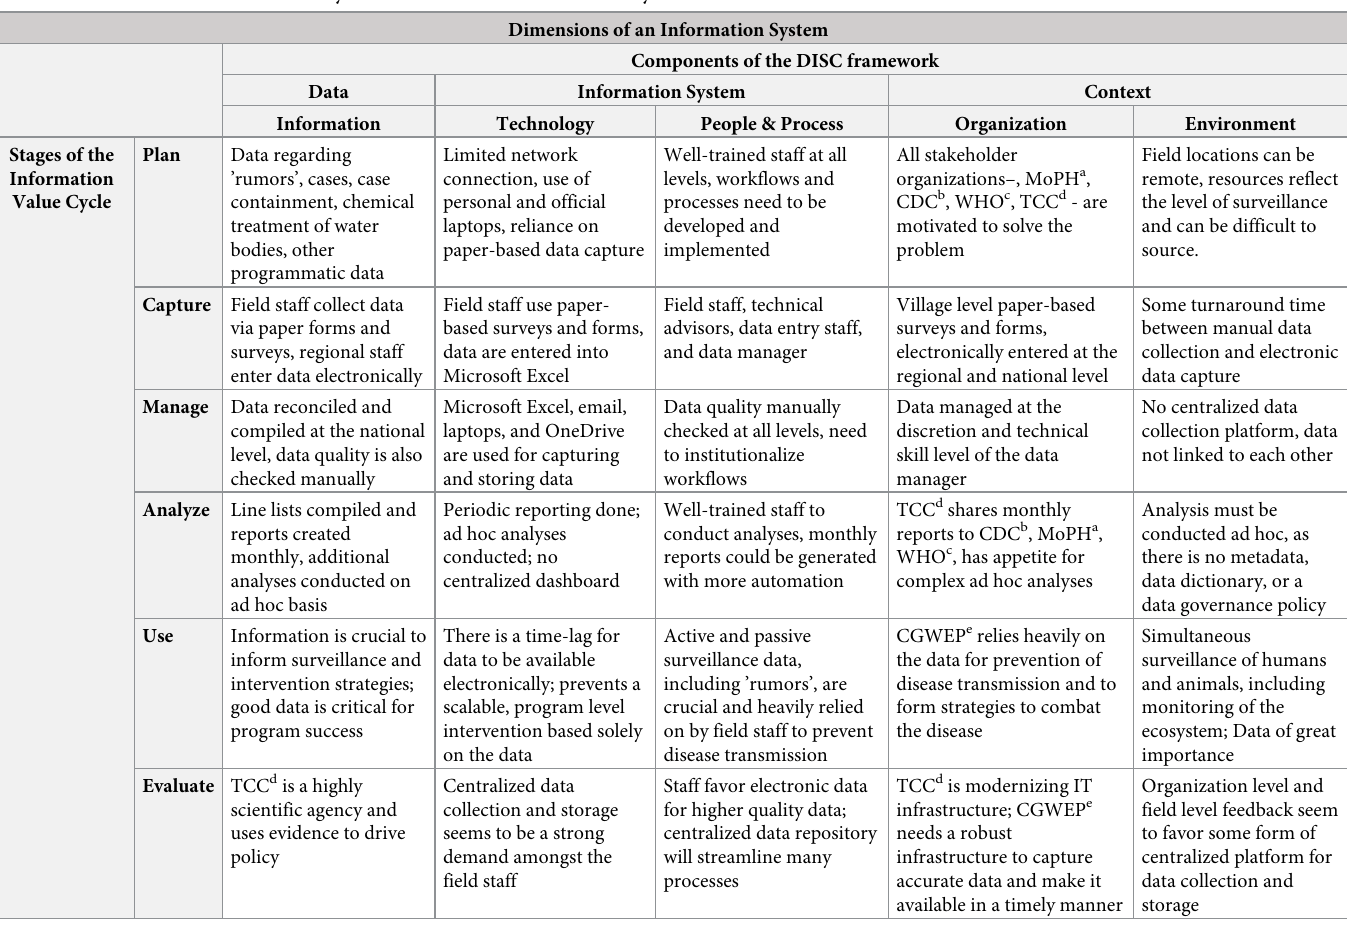
Table 3. Dimensions of an information system: the IVC-DISC contextual analysis